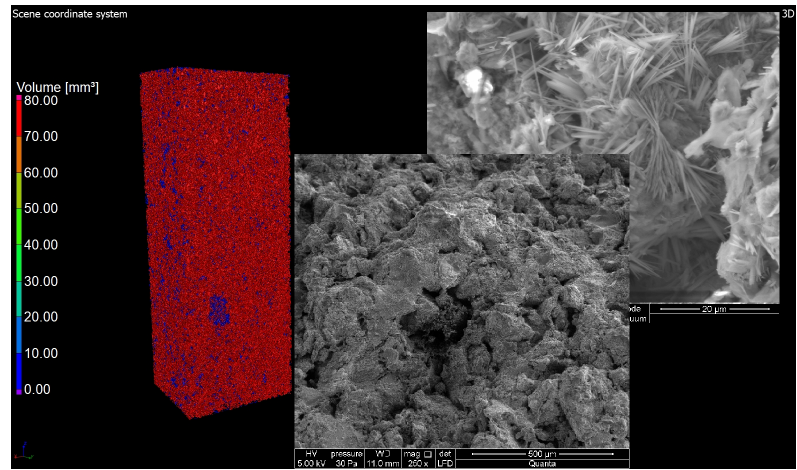
Figure 19. Image of the porous structure of silicate brick with 90% GS.